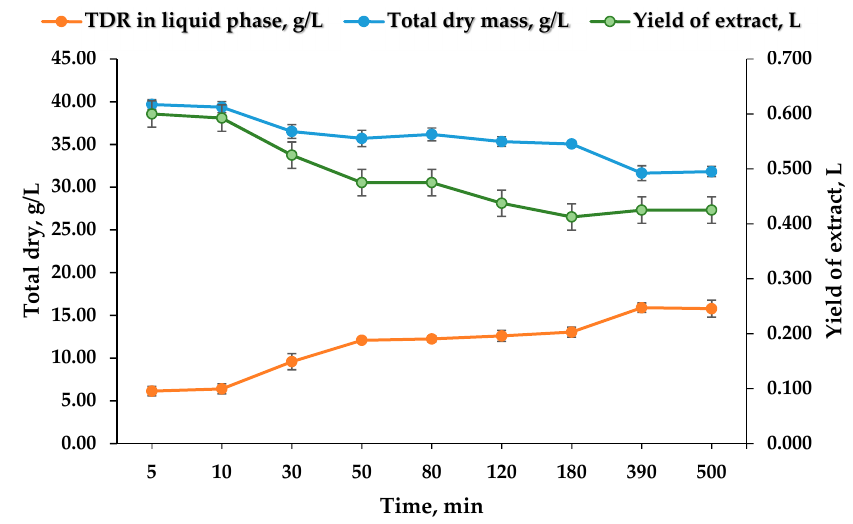
Figure 3. Kinetic curves by the total dry residue (TDR) in the liquid phase, the total dry mass in g/L, and the yield of the extract received after extraction (L) of the Cistus incanus leaves, stalks, and buds.